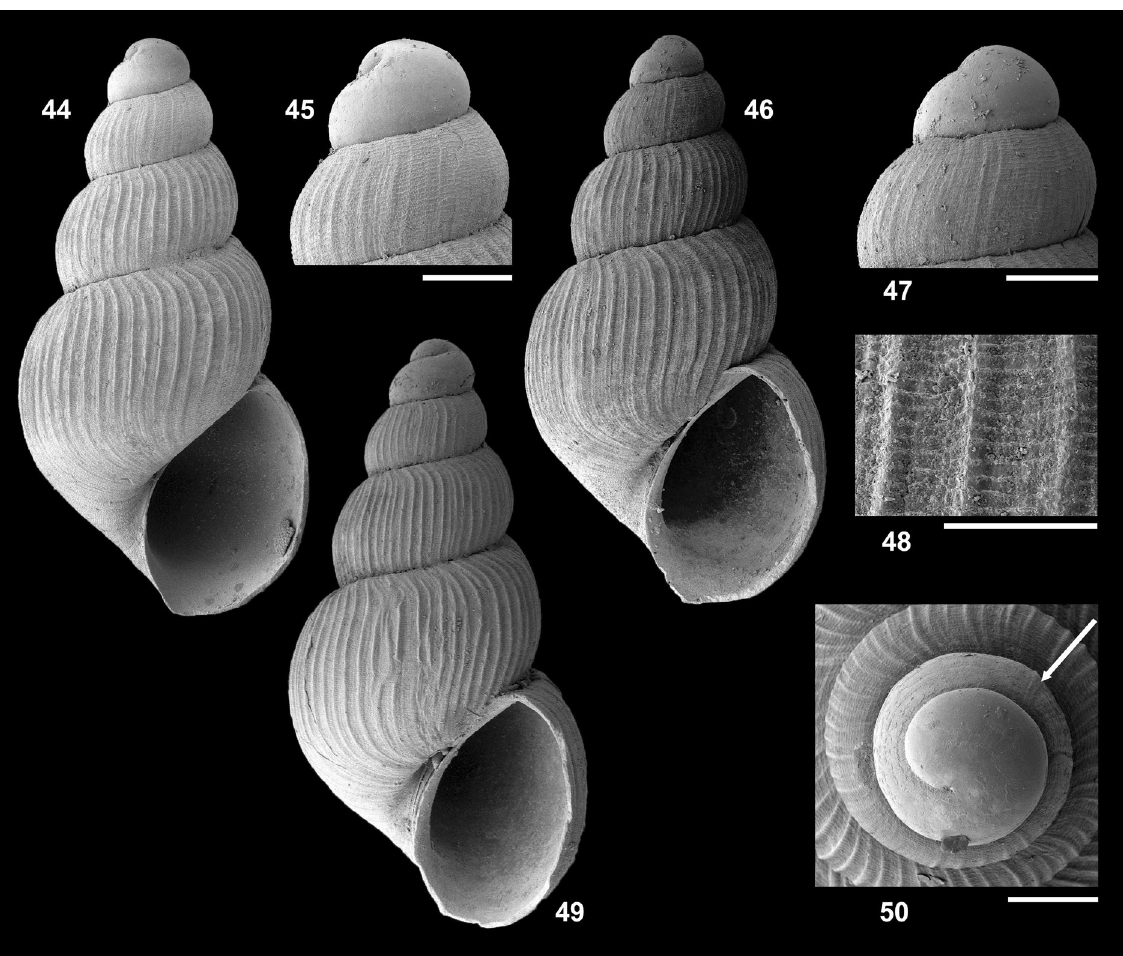
46–50 . Arguin South 3 Canyon, MSM16/3-GeoB14858. 46–48 . Paratype (SMF358971). 46 . Ventral view, H = 2.4 mm, W = 1.2 mm, Ha = 1.0 mm. 47 . Protoconch, Wp = 0.40 mm. 48 . Sculpture body Wp = 0.4 mm. 50 . Paratype (SMF358971), apical view protoconch, Wp = 0.44 mm, arrow indicates lip. Scale bars: 44–47, 49–50 = 0.2 mm; 48 = 0.1